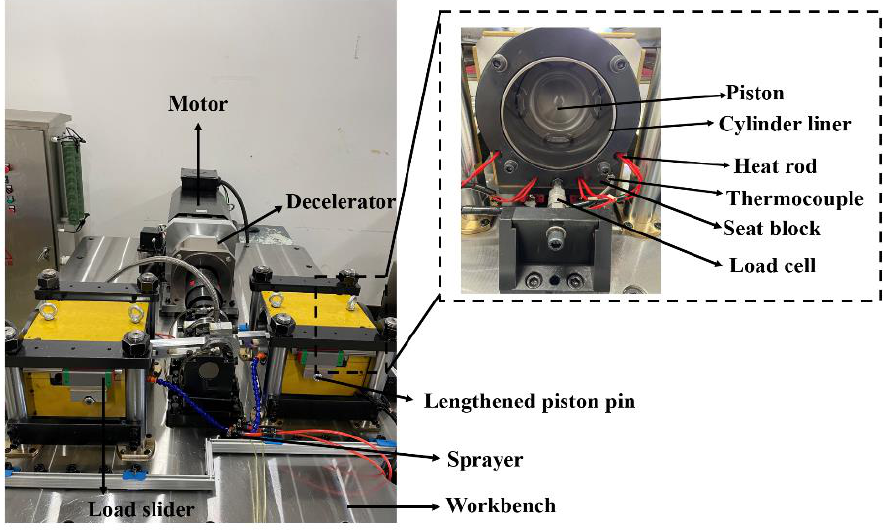
Figure 2. Overall appearance of the apparatus.